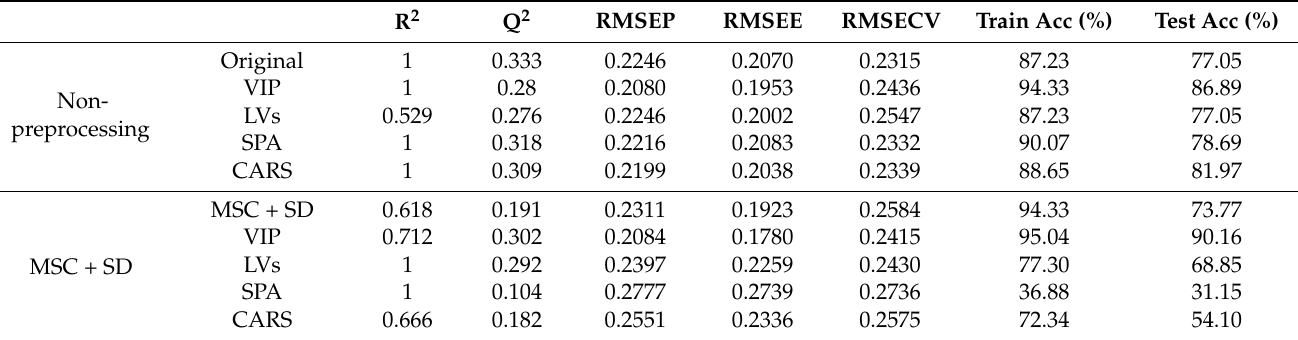
Table 2. Parameters of PLS-DA Model Based on